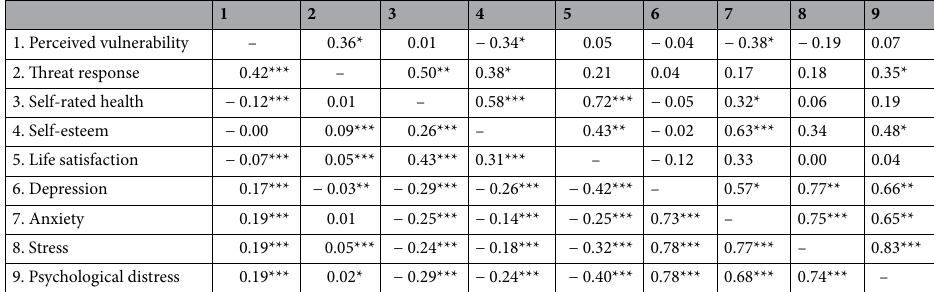
Table 4. Multilevel correlations of perceived vulnerability and threat response with well-being outcomes. Correlations at the individual level are provided below the diagonal while those at the society level are provided above the diagonal. * p < 0.05, ** p < 0.01, *** p < 0.001.